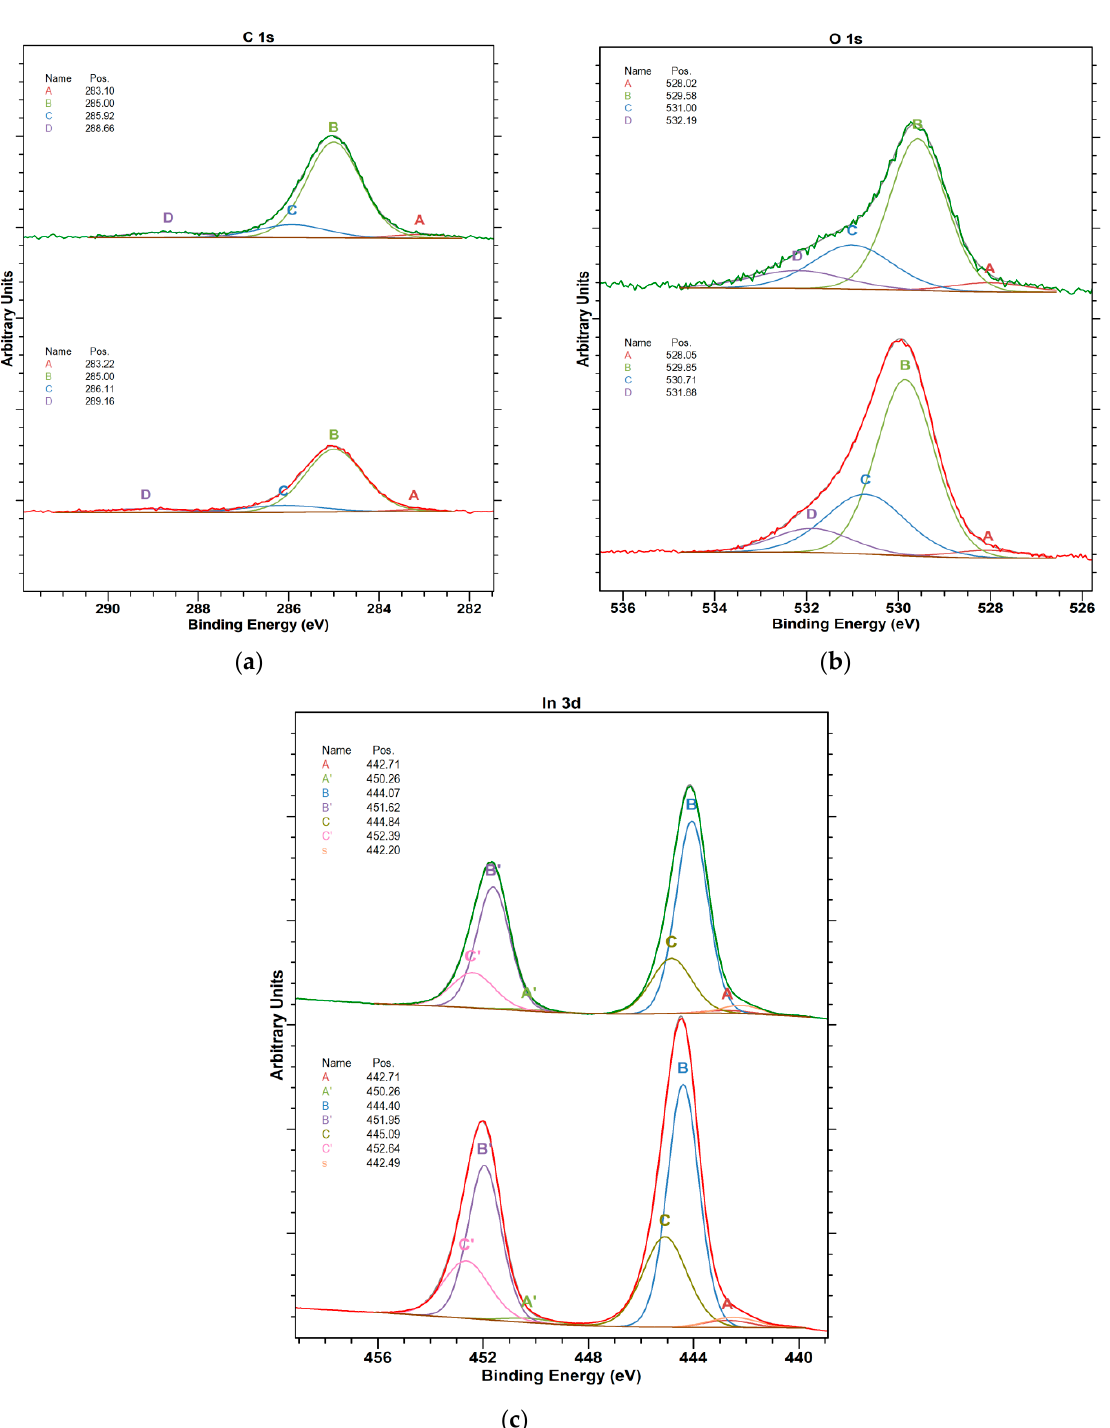
Figure 4. High-resolution XP spectra of In 2 O 3 layers ( a ) C 1s (A: C-metal; carbon-metal bonding, carbides, B: C-C; organic carbon, the BE suggests that it can be sp2 in majority, C: C-O; alcohol or ether groups, D: COOH, carboxylic or peptide groups), ( b ) O 1s (A: O-metal, defected oxide structure, presence of oxygen vacancies, B: O-metal, lattice oxides, C: OH, hydroxyl groups at the surface, D: O-C + H 2 O, organic compounds and water, oxygen bonded to short aliphatic chains + adsorbed water), ( c ) In 3d (A: In-C; surface carbides, B: In 3+ -O; In 2 O 3 lattice oxide, C: In 3+ -OH; In(OH) 3 ) (where: name-spectrum component (in case of doublet excitation, the maxima are depicted as A and A’, etc.). The high-resolution spectra for ITO samples are collected in Figure